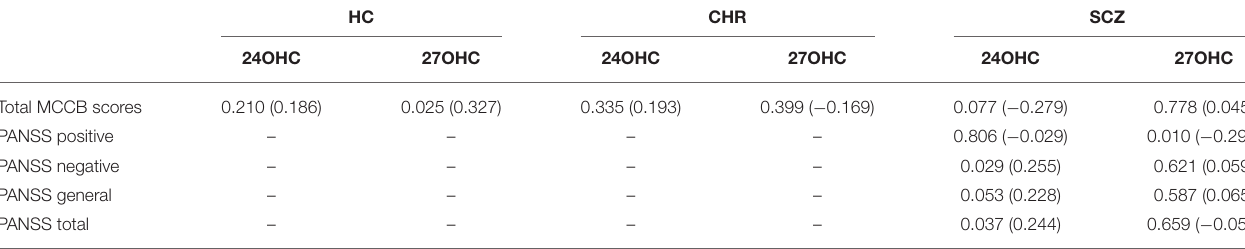
TABLE 2 | Associations between oxysterols and clinical assessments in schizophrenia patients, CHR individuals, and HCs.